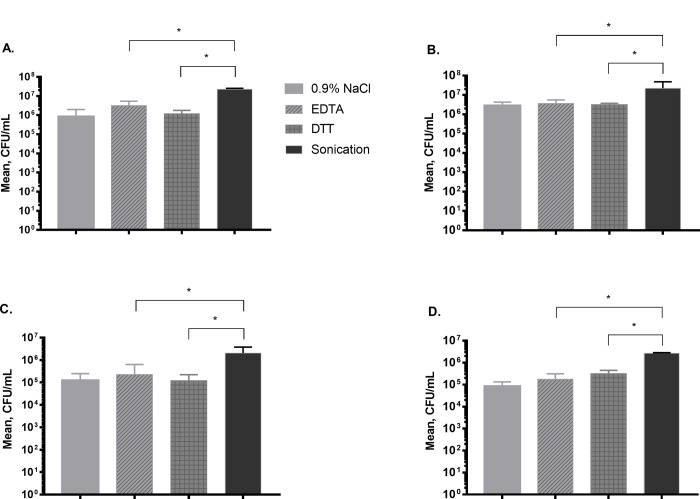
Quantitative analysis and comparison of biofilm dislodging methods.(A) S. epidermidis biofilm. (B) S. aureus biofilm. (C) E. coli biofilm. (D) P. aeruginosa biofilm. Mean values are shown, error bars represent standard deviation. * Statistically significant difference (p < 0.05). 0.9% NaCl represents an untreated control. EDTA, ethylenediaminetetraacetic acid. DTT, dithiothreitol.